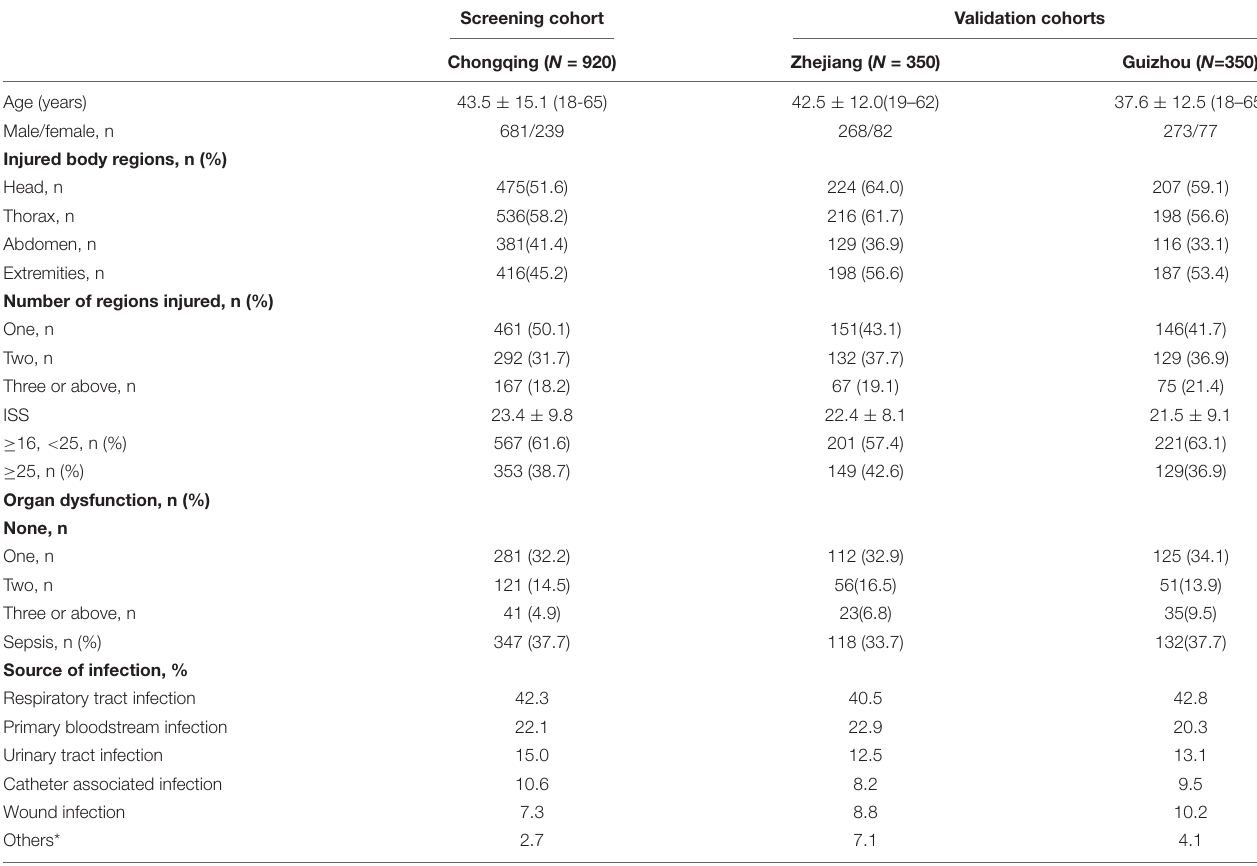
TABLE 1 | Overall clinical characteristics of patients with major trauma.